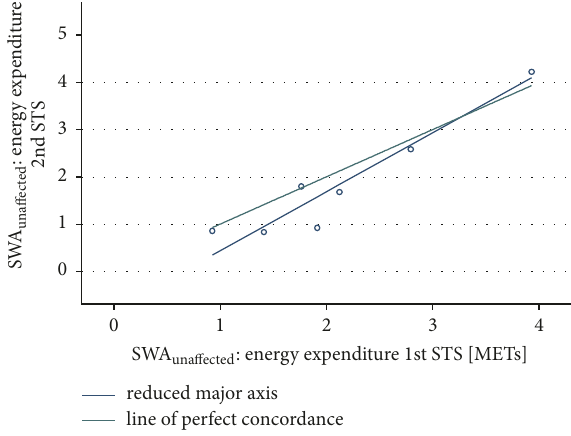
Figure 3: SWA unaffected : energy expenditure between 1st and 2nd bout of walking.